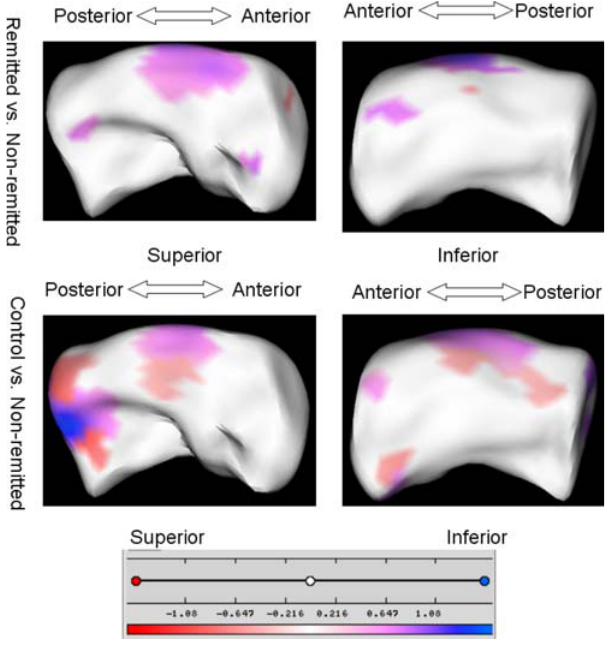
Figure 5. The analysis of left hippocampus: remitted vs. non- remitted, control vs. non-remitted. The distance maps masked by the significance maps are shown on a representative hippocampus. The scale of color code is illustrated in a color bar and in